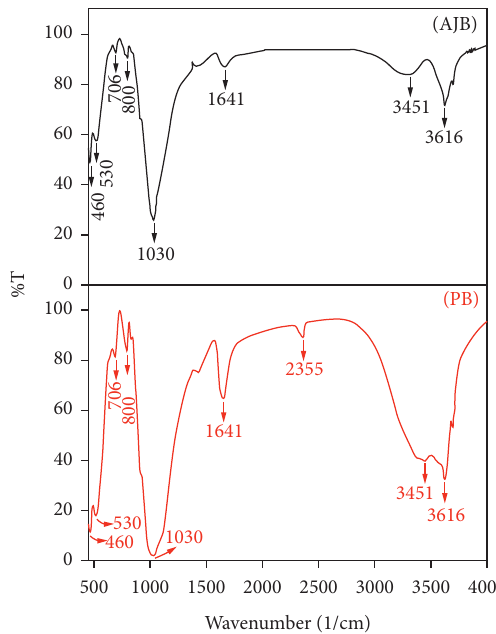
Figure 2: FTIR spectra of PB and AJB.